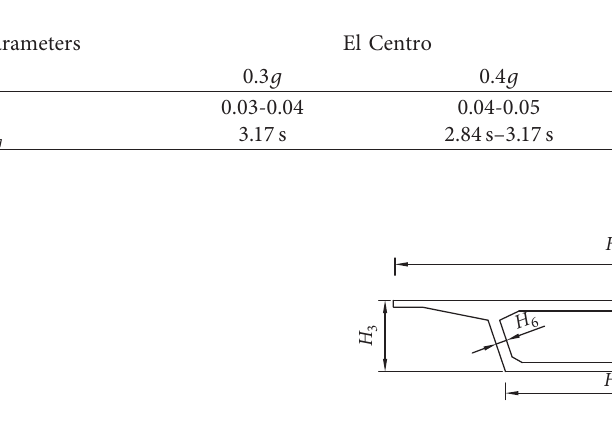
Figure 19: Cross section of span double line box